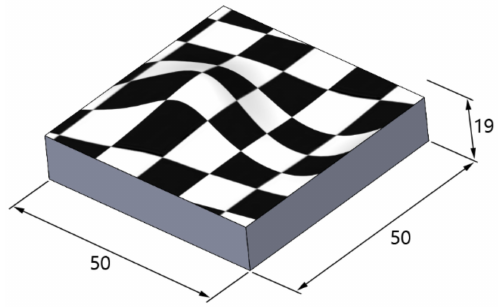
Figure 1. Model of the proposed sample with freeform surface.